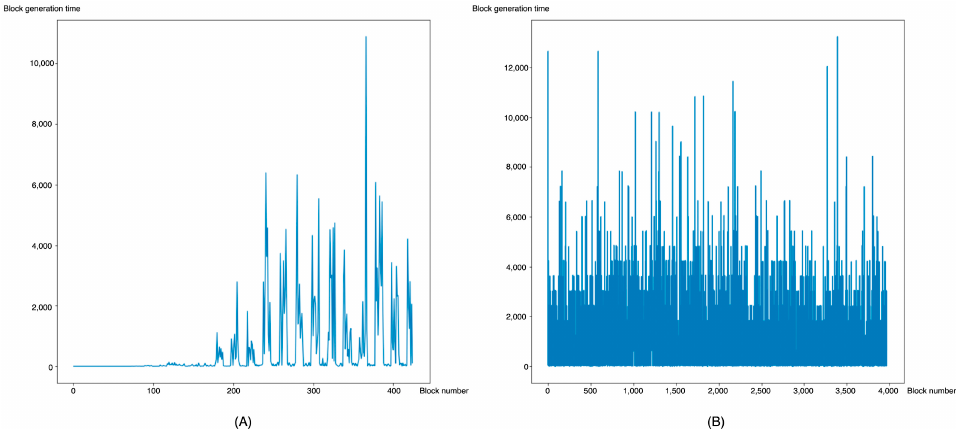
Figure 18. Block generation time in blockchains (( A ) Bitcoin; ( B ) Ethereum).